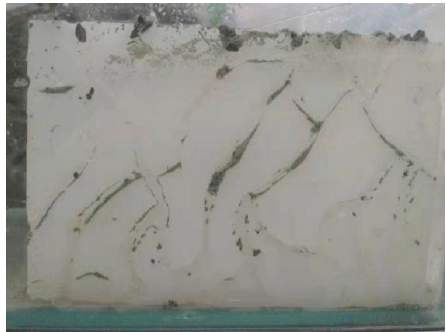
Figure 8. Blockage of full-graded blockage.